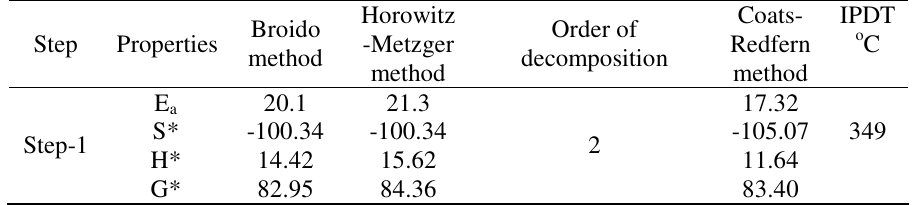
(kJ/mol), S* (J/Kmol), H* a